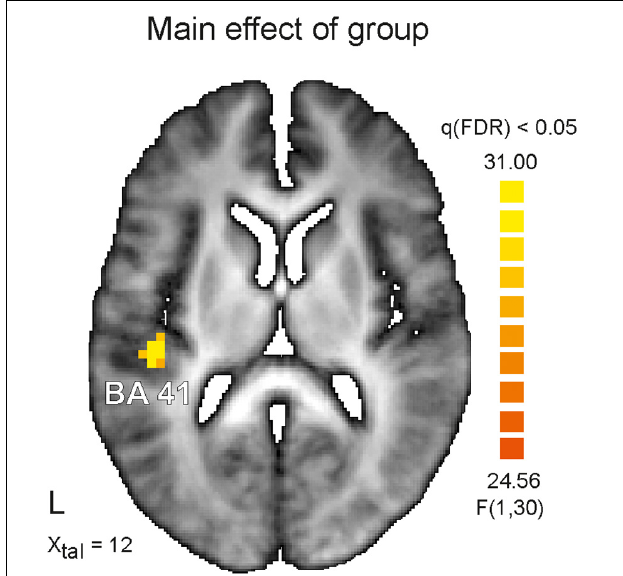
FIGURE 2 | Depicted is horizontal view on the brain at the Talairach coordinate X = 12. On the left (L) hemisphere color coded cluster within the auditory cortex is shown. The identified cluster occupies Brodmann area 41 (BA41) and survived significance level of q < 0.05 corrected for multiple comparisons (false discovery rate, FDR) for the main factor Asperger’s syndrome. Healthy control subjects showed in this area stronger activation than Asperger’s subjects for both experimental conditions (audiovisual congruent and incongruent). Color coded is the F